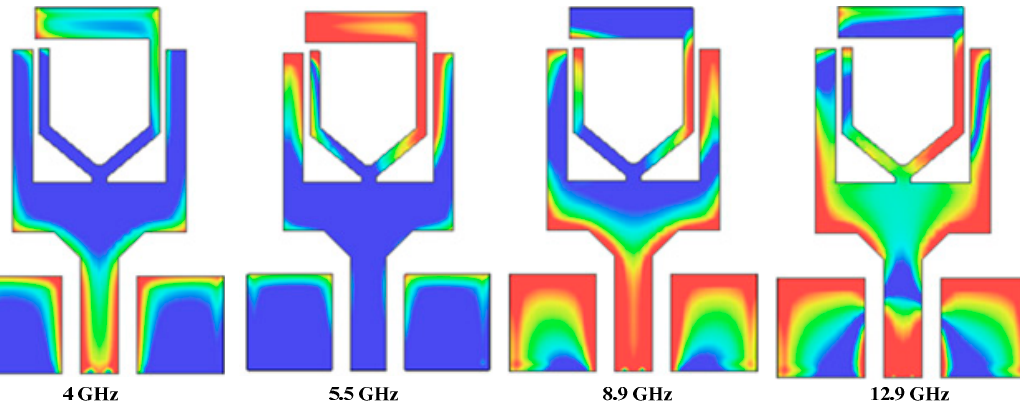
Figure 7. Current density of proposed notch band extended UWB antenna at various frequencies.